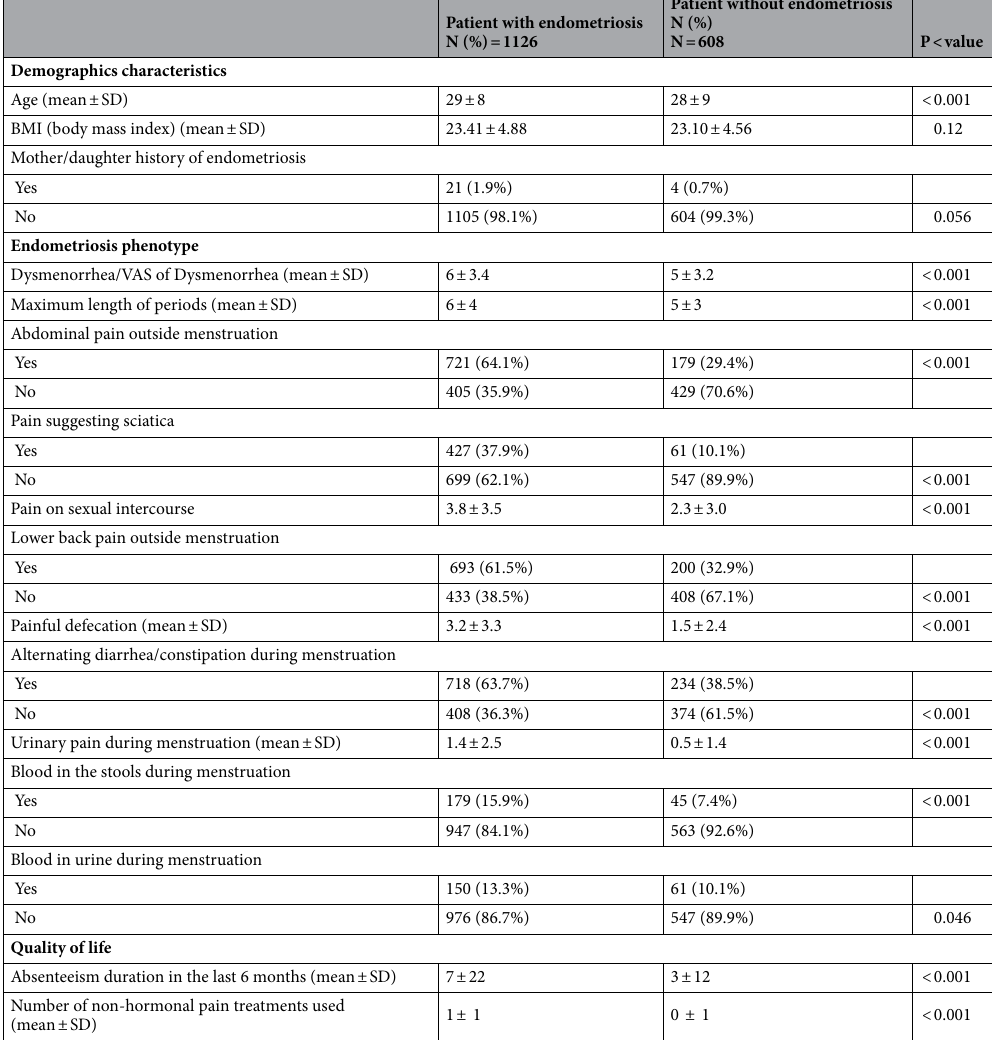
Table 1. Demographic characteristics of the training dataset for patient with and without